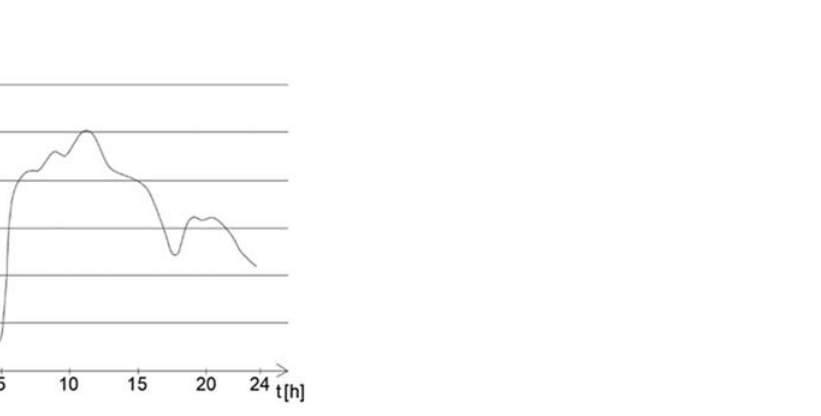
Figure 16. Proposed course of daily energy consumption for Thursday and its comparison with the standard.